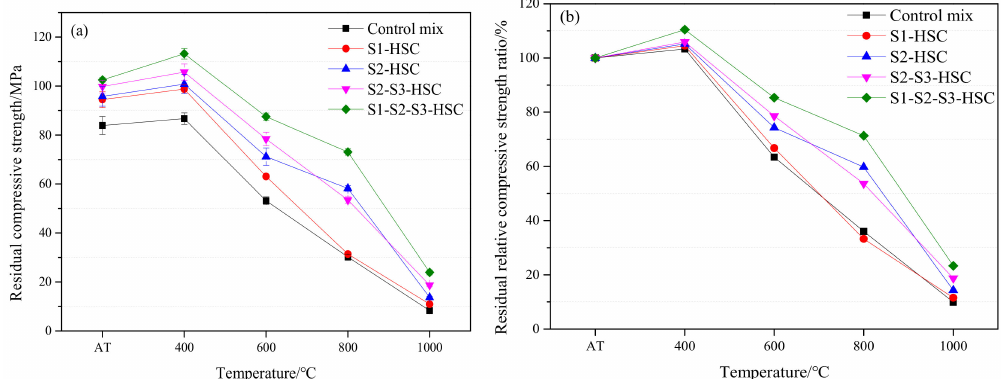
Figure 6. Mechanical properties of concrete subjected to elevated temperatures: ( a ) residual compressive strength and ( b ) residual relative compressive strength